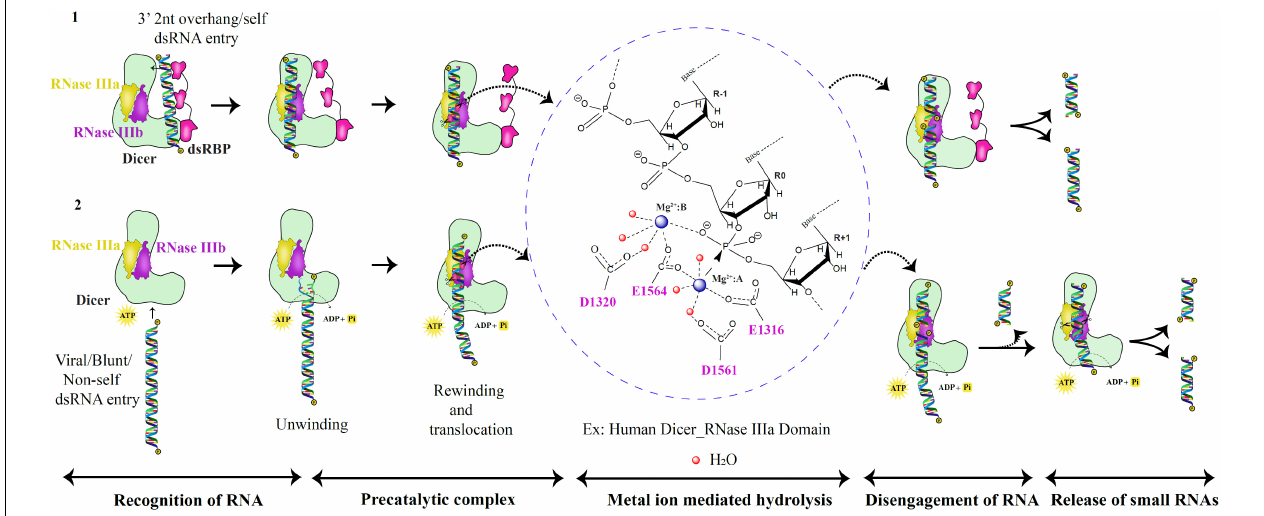
FIGURE 7 | RNase III catalytic mechanism of the Dicer family of proteins. Based on the catalytic pathway proposed for prokaryotic RNase III enzymes, the eukaryotic dsRNA processing by Dicer is classified into five critical steps as shown above (Ji, 2006; Meng and Nicholson, 2008; Nicholson, 2014). In the first scenario, the PAZ domain recognizes dsRNA substrates with 2nt 3 (cid:48) overhang. Besides, the dsRNA substrate is placed between the PAZ and RNase III domains to produce unique lengths of sRNAs via two catalytic metal ion mechanisms. In the second scenario, dsRNA with blunt termini are recognized by the helicase domain in an ATP-dependent